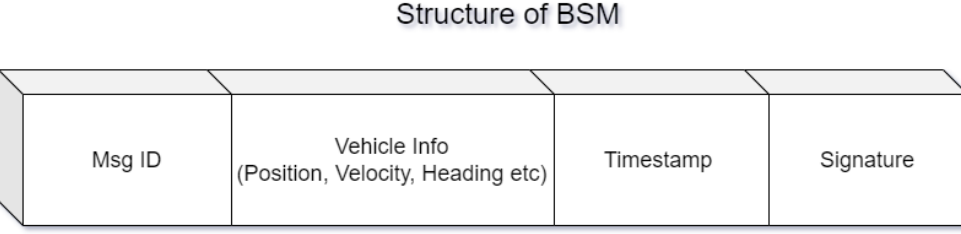
Figure 3. Showing the structure of a basic safety